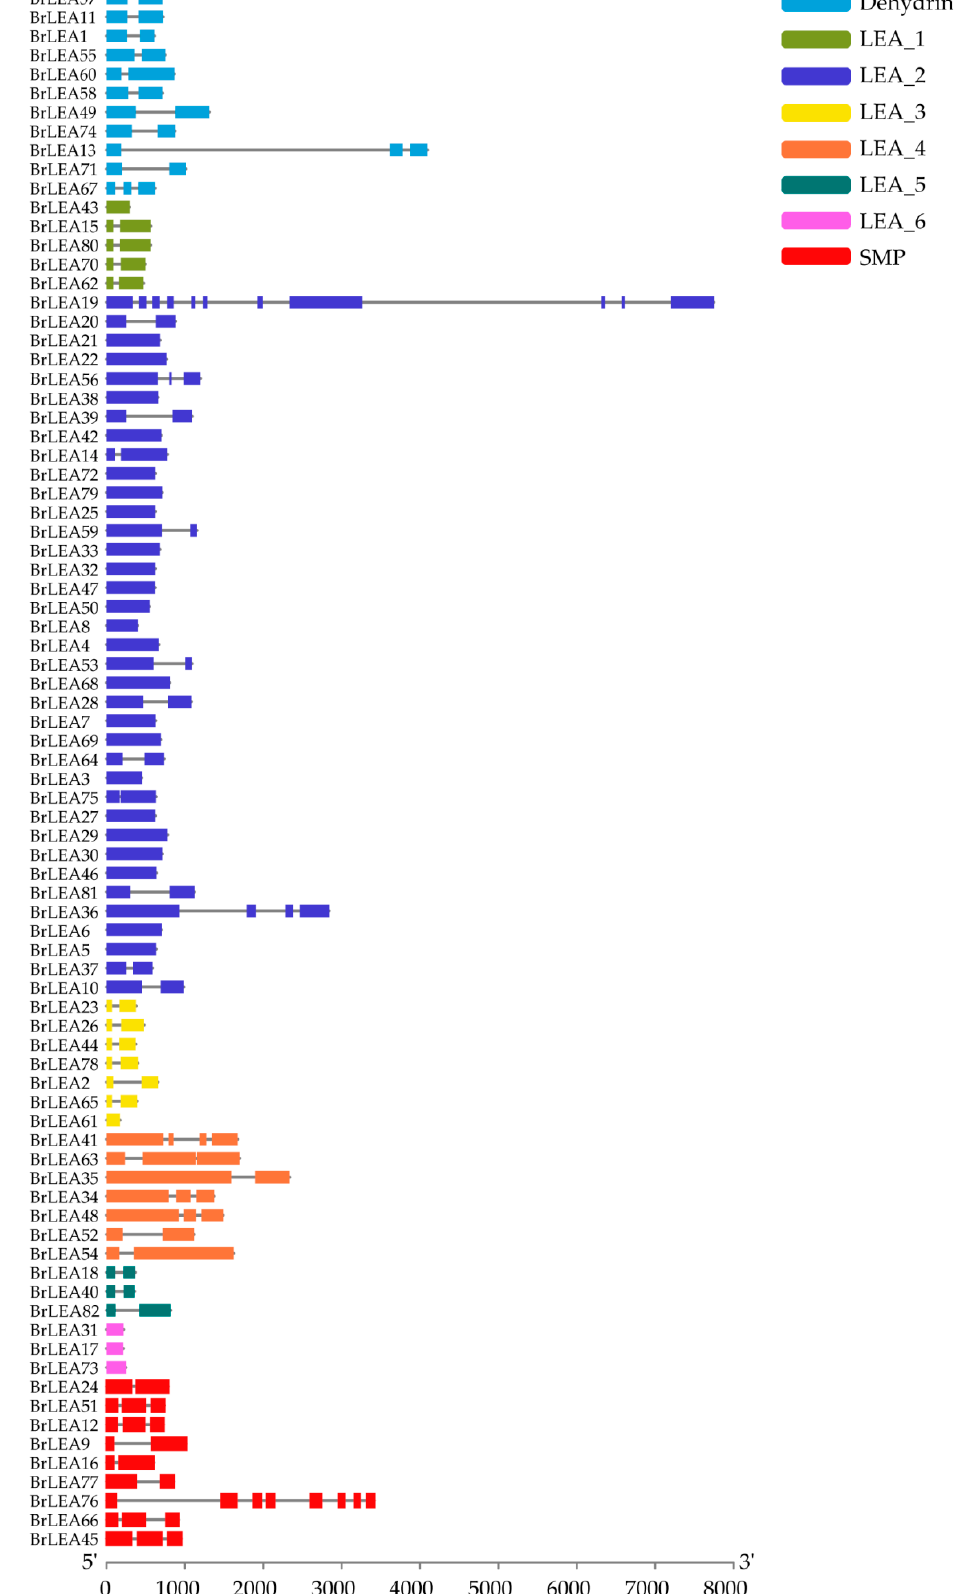
Figure 3. Exon–intron structures of the BrLEA gene family.